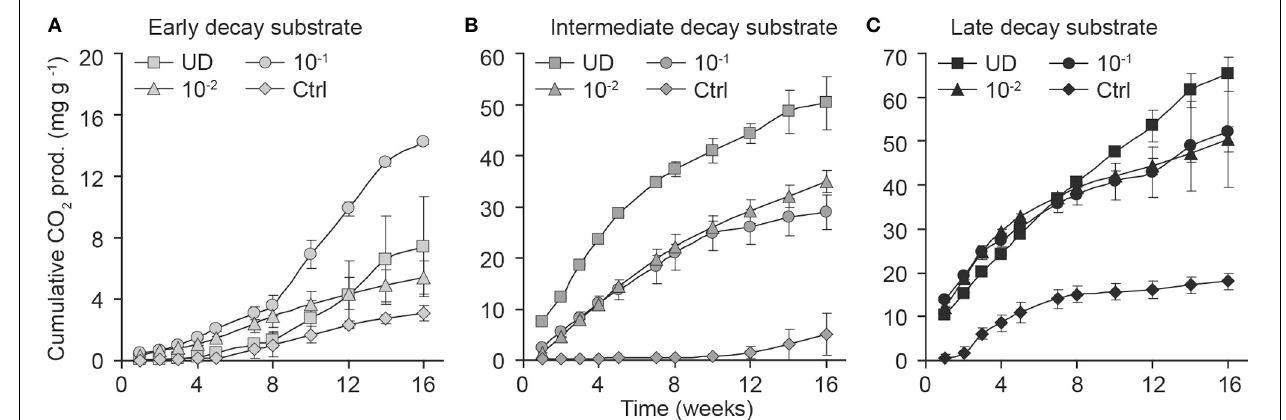
FIGURE 2 | Effect of dilution on the production of CO 2 (cumulativemg of CO 2 perg of substrate; indm) within early- (A), intermediate- (B), and late- (C) decay stages. Dilution of fungal diversity is shown by symbols as undiluted fungal inoculum (squares), dilution 10 − 1 g inoculum/g